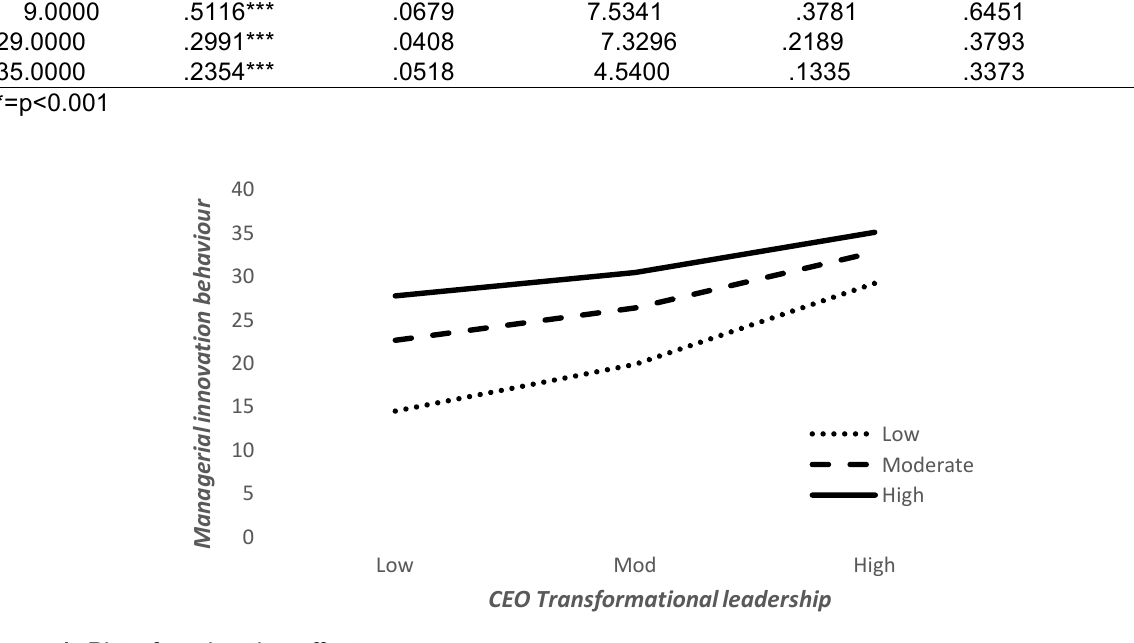
Figure 1: Plot of moderation